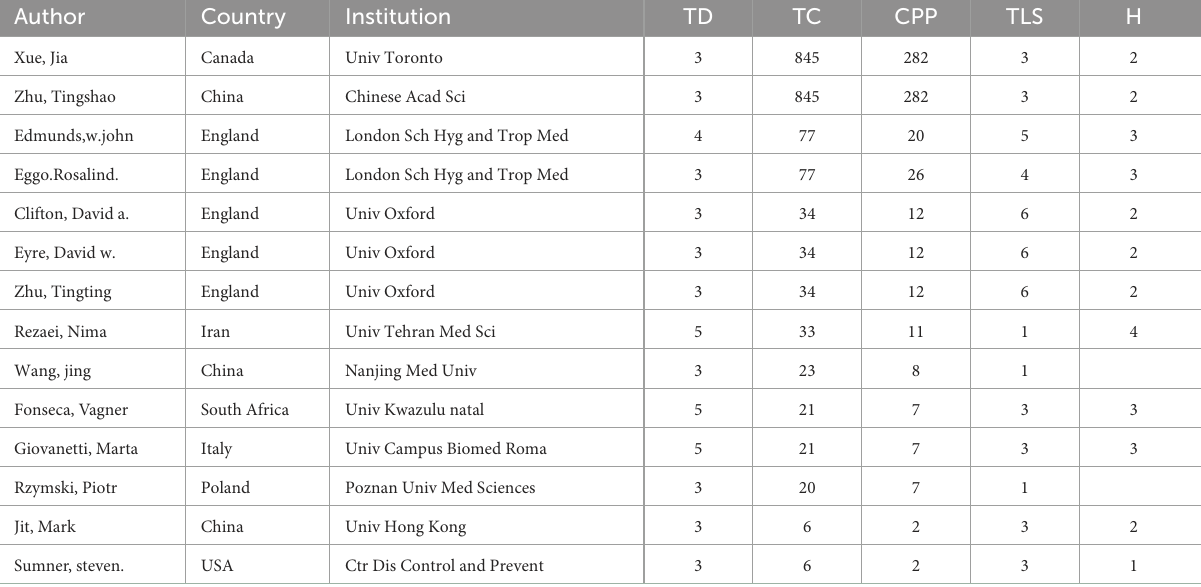
TABLE 2 Top 15 authors with the most